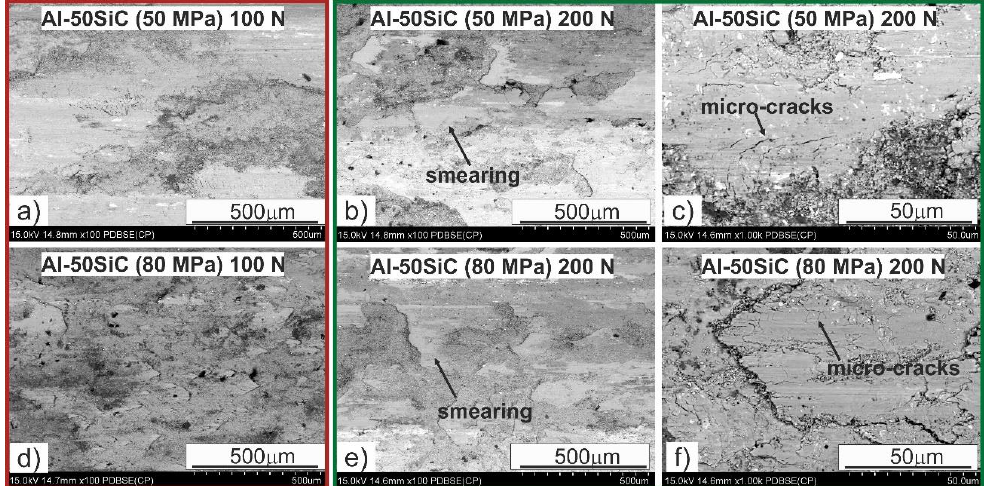
Figure 9. Al-50SiC specimen surfaces after tribological tests.